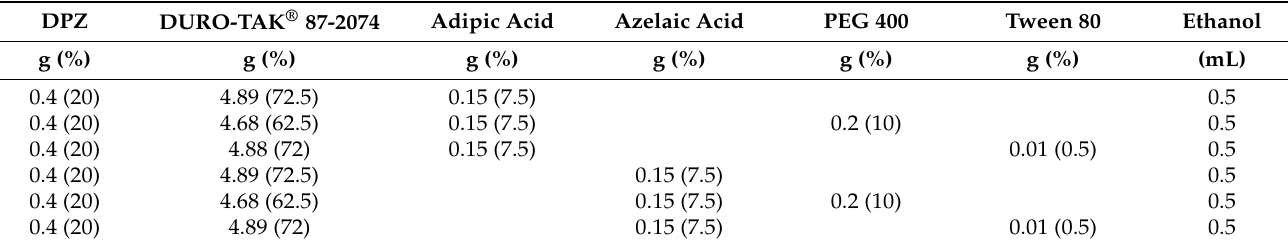
Table 5. DPZ IL patch formulation using DURO-TAK ®